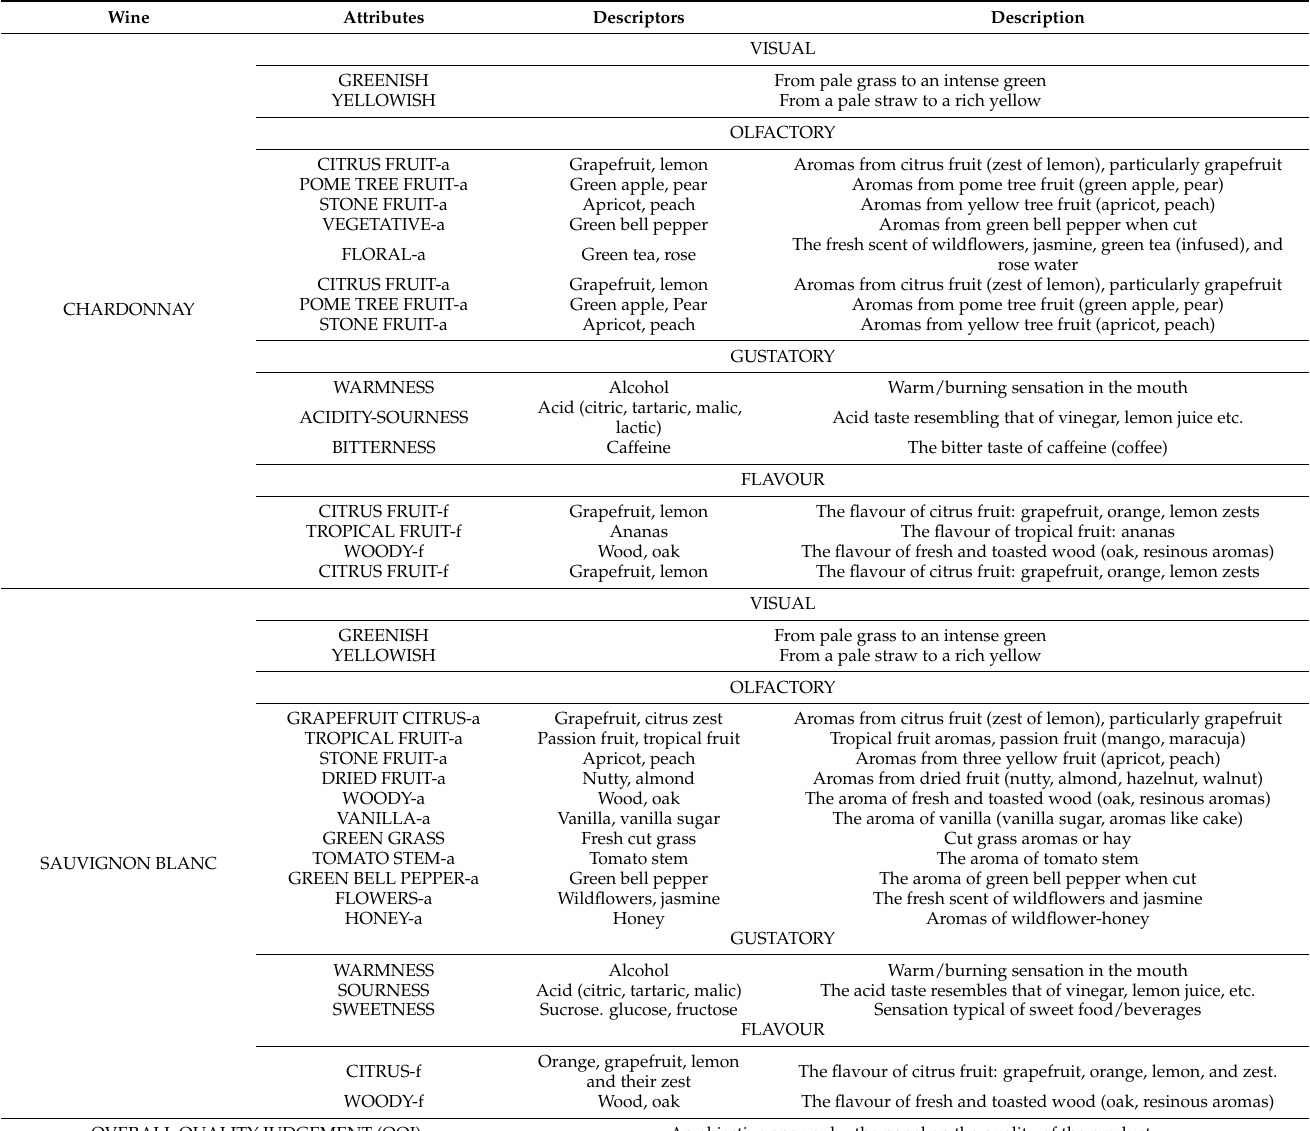
Table 4. List of attributes relevant to the sensory profile of Chardonnay and Sauvignon Blanc